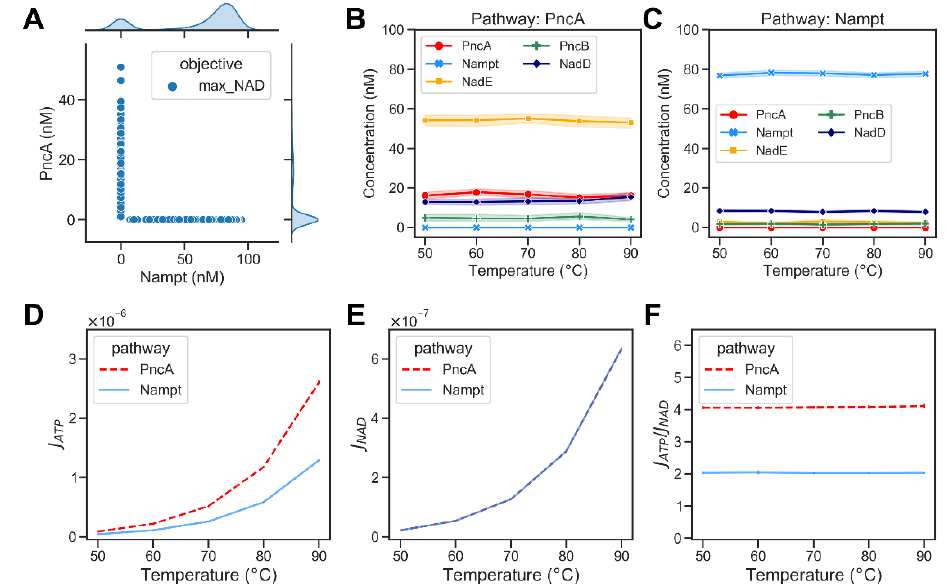
Figure 6. Optimization results of maximizing the NAD concentration of bacterial NAD biosynthetic pathways. ( A ) A scatter plot showing the abundances of Nampt versus PncA when maximizing the NAD production ratio. Each dot represents an optimisation result. The marginal plots show kernel density estimate plots that show the enzyme abundance distributions in the optimisation results. ( B ) Optimized abundance of enzymes at different temperatures in PncA pathway. ( C ) Optimized abundance of enzymes from Nampt pathway. ( D ) The ATP consumption flux, J ATP , in PncA (dashed red curve) and Nampt (blue curve) pathway at different temperature ( E ) The NAD production flux, J NAD , in PncA and Nampt pathways at different temperatures. ( F ) The ratio of ATP consumption flux to NAD production flux at different temperatures in PncA and Nampt pathways.